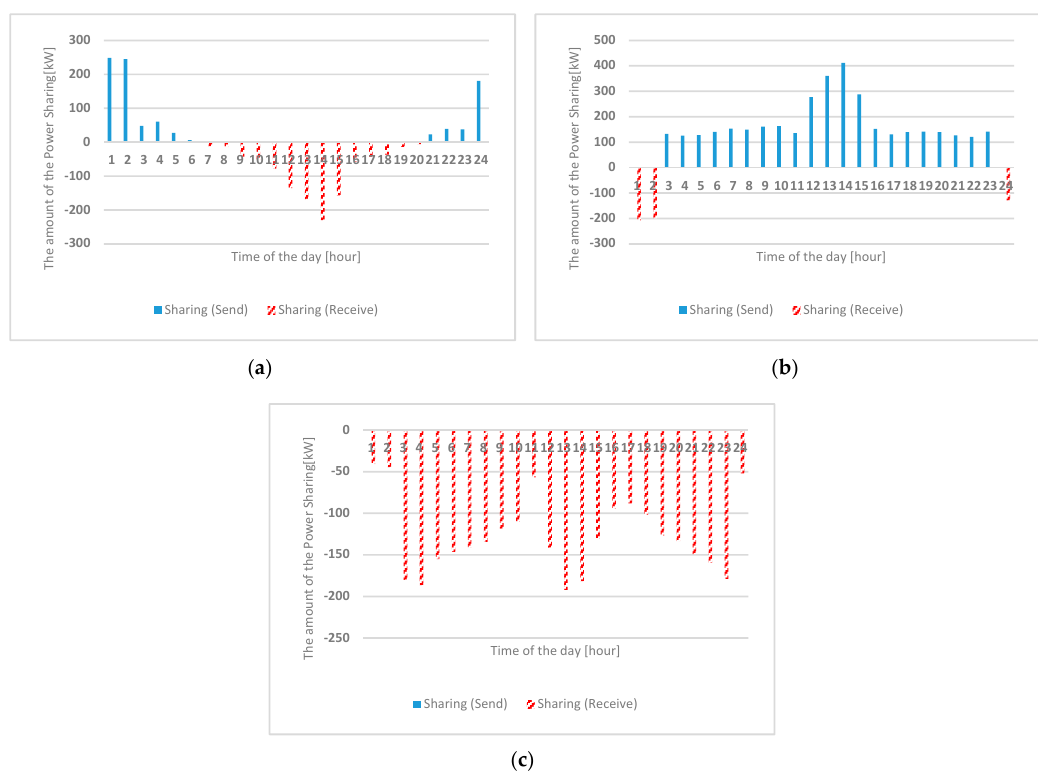
Figure 8. Power transaction with utility grid ( a ) MG1, ( b ) MG2, ( c ) MG3.